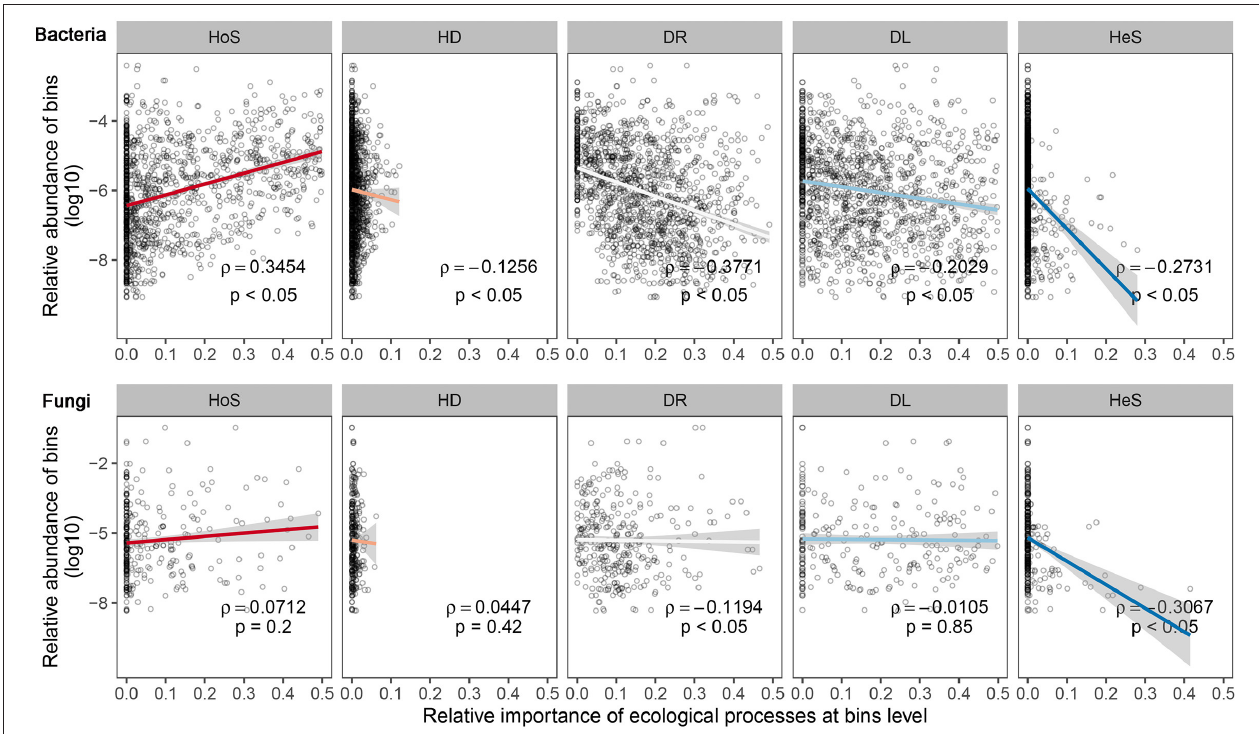
FIGURE 5 | Relationship of relative abundance of bacterial and fungal community taxa bins and their ecological processes of assembly at the bin level. Different sub-captions indicate different community assembly processes: HoS, homogeneous selection; HD, homogeneous dispersal; DR, ecological drift (i.e., undominated processes, including drift, diversification, weak selection, and/or weak dispersal); DL, dispersal limitation; HeS, heterogeneous selection. The horizontal axis depicts assembly processes’ relative importance per bins’ relative abundance; and the vertical axis is the bins’ relative abundance, which has been transformed by logarithmic conversion. For each sub-figure, we add a tendency line (ggplot2 package, “lm” method); 95% confidence interval of the tendency line is depicted by shading. Significance of Spearman’s rank correlation: p, coefficient of Spearman’s rank correlation: ρ